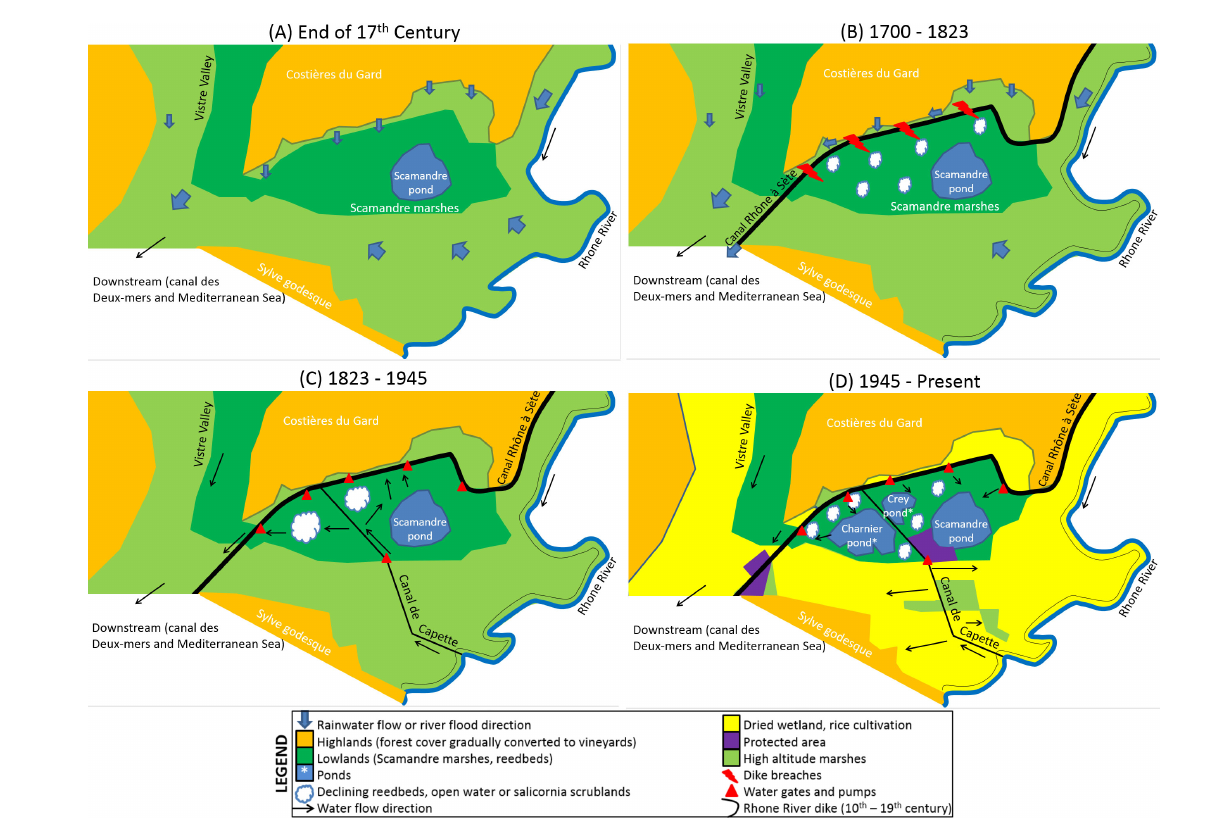
Fig. 2. Simplified maps of major land-cover changes in Scamandre Marshes, 1600–2014, in the Camargue Biosphere Reserve,